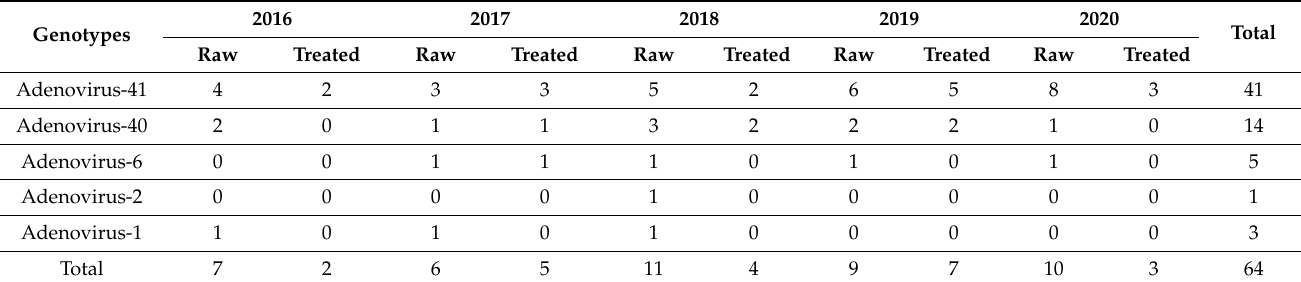
Table 4. Environmental positive HAdV genotypes distribution in raw and treated samples from 2016 to